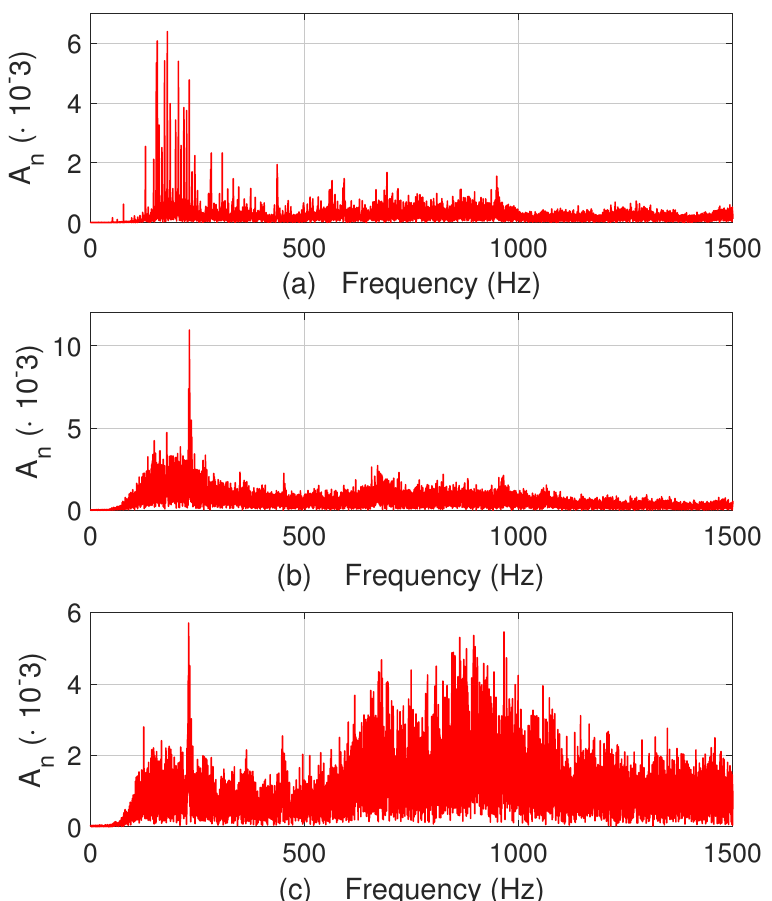
Figure 8. Frequency spectrum of the environmental noise in the proximity of the left front wheel when ( a ) the car is started but not moving, ( b ) the car is traveling along a straight with asphalt at 60 km/h, and ( c ) the car is traveling along a straight with gravel at 20 km/h. The amplitude of the time-domain signal was normalized between [ −